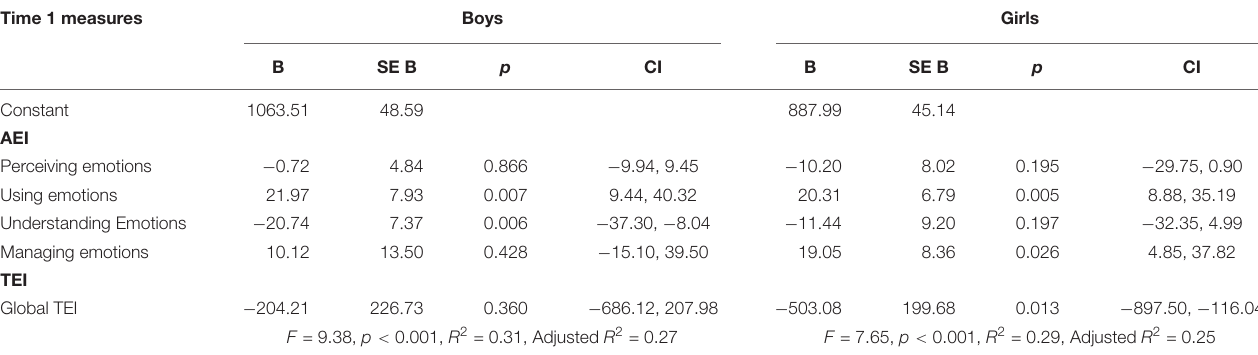
TABLE 4 | Bootstrapped regression analysis with AEI and TEI as predictors of prolonged loneliness for boys and girls. Time 1 measures Boys Girls B SE B